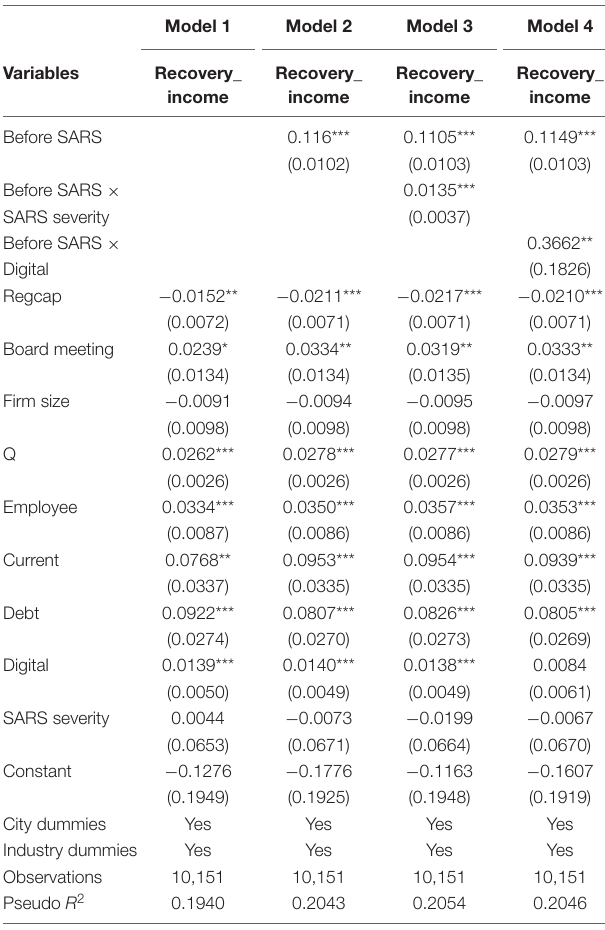
TABLE 4 | Results from the other indicators of firms’